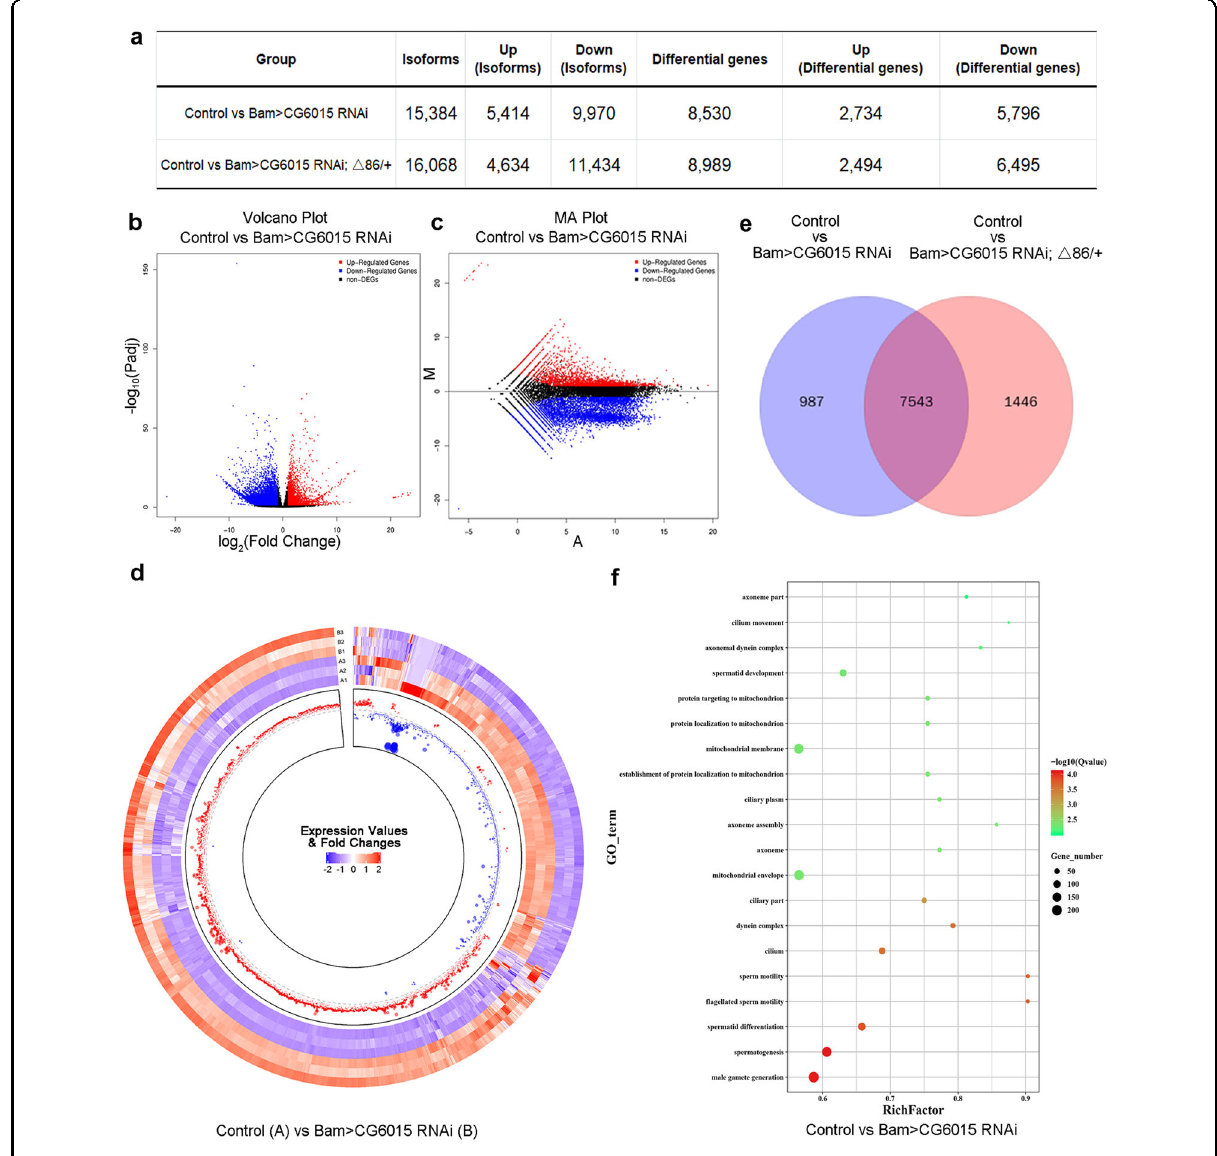
Fig. 4 Reduction of CG6015 in spermatogonia induced transcript alterations as assessed using RNA-seq analysis. a Number of isoforms and genes identi fi ed by the RNA-seq in testes. b Volcano plots based on – log 10 Padj and log 2 FC from the comparison of the control (W 1118 ) and Bam> CG6015 RNAi groups. c MA plots from the comparison of the control (W 1118 ) and Bam> CG6015 RNAi groups. d Circular heatmap of differentially expressed genes from the comparison of the control (W 1118 ) and Bam> CG6015 RNAi groups. The outer and inner tracks represent the expression values and fold changes, respectively. For both the expression value and fold change, blue and red scales represented low and high expression correspondingly. e Venn diagrams comparing the sets of differentially expressed genes. f GO analysis of the sets of differentially expressed genes from the comparison of the control (W 1118 ) and Bam> CG6015 RNAi